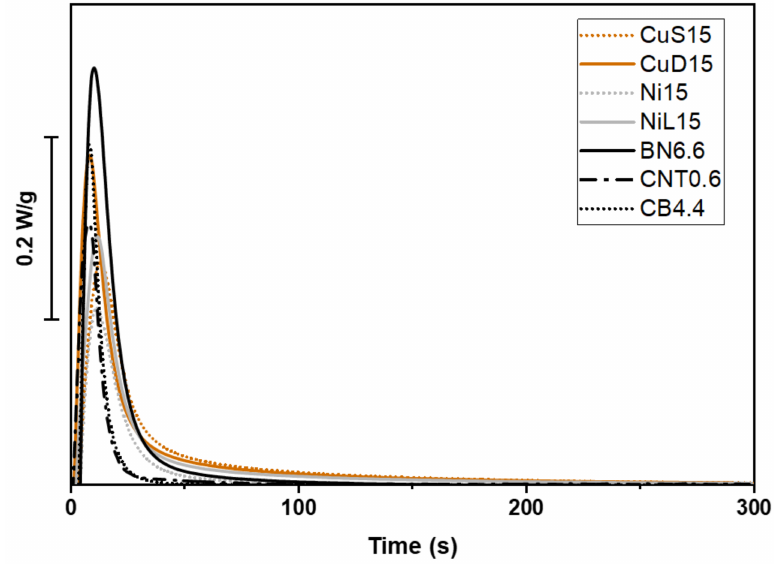
Figure 3. DSC thermogram of isothermal curing at 150 ◦ C for the tested